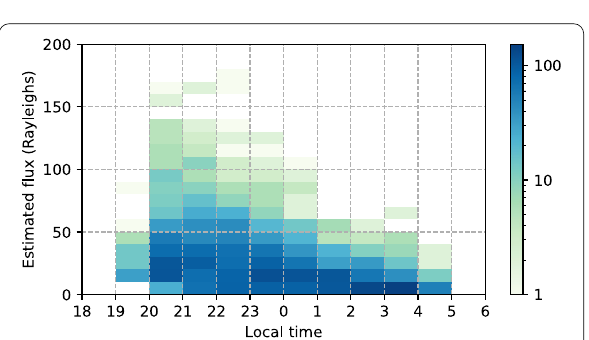
Fig. 8 Two-dimensional histogram of the estimated EUV flux when the ISS latitude was less than 20 ◦ for each local time interval in